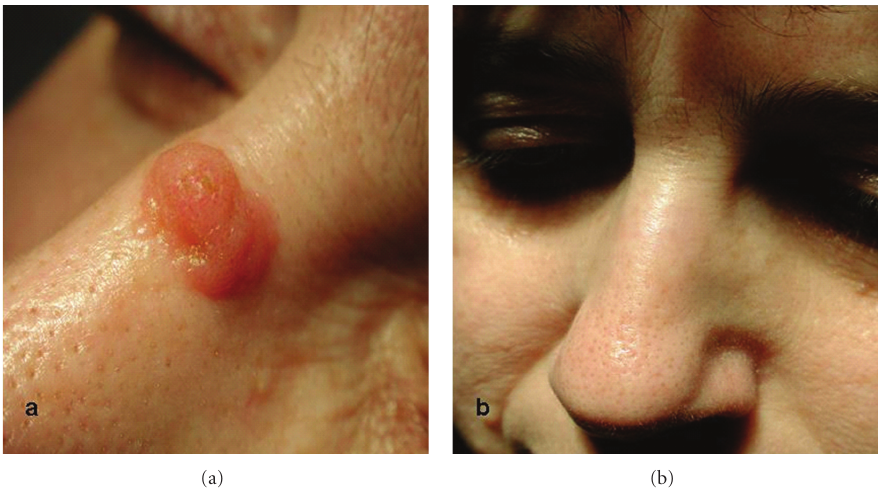
Figure 9: Inverted follicular keratosis at first (a) and after (b) one treatment with CO 2 laser.